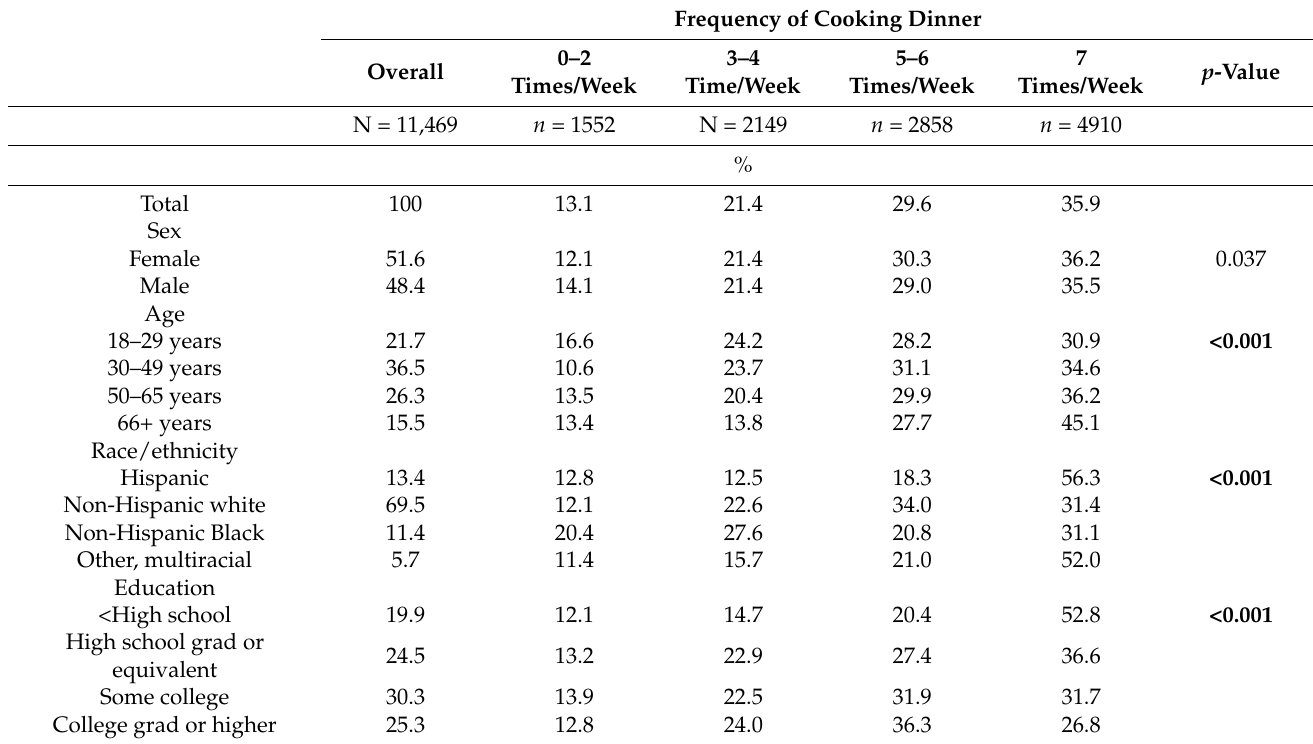
Table 1. Characteristics of the study sample, by frequency of cooking dinner, NHANES